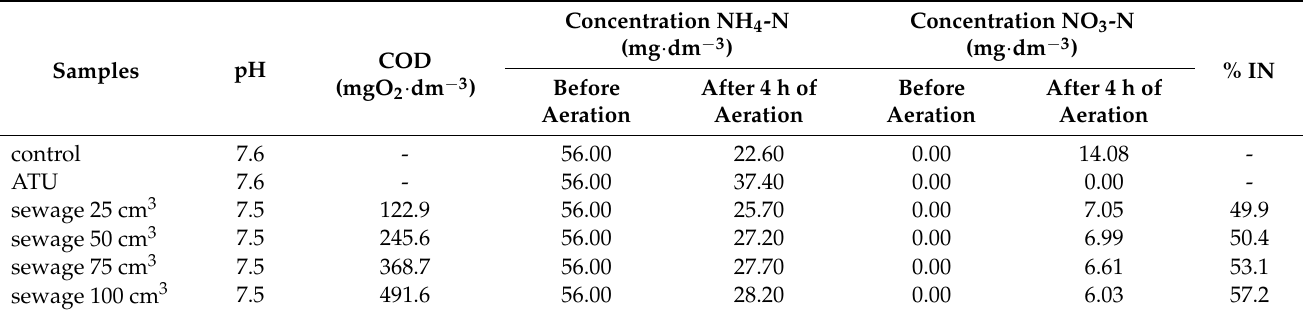
Table 9. Influence of COD of industrial wastewater from solvent (butyl acetate, ethyl acetate) production on the nitrification inhibition in activated sludge under laboratory conditions.